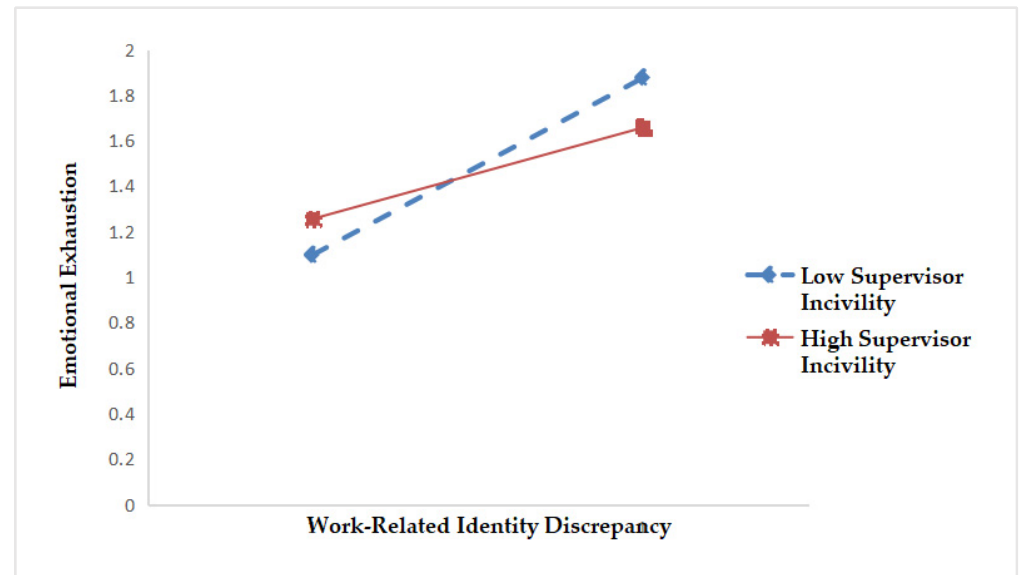
Figure 2. The moderating effect of supervisor incivility on the relationship between work-related identity discrepancy and emotional exhaustion.